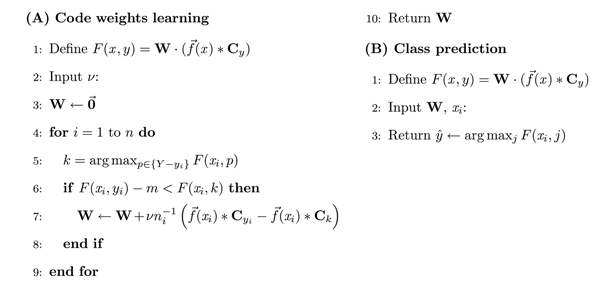
Pseudocode for the ranking perceptron algorithm used to learn code weighting. In the pseudocode, ν is the learning rate; ni = |{yj : yj = yi}| for balanced-loss, and ni = 1 for zero-one loss.